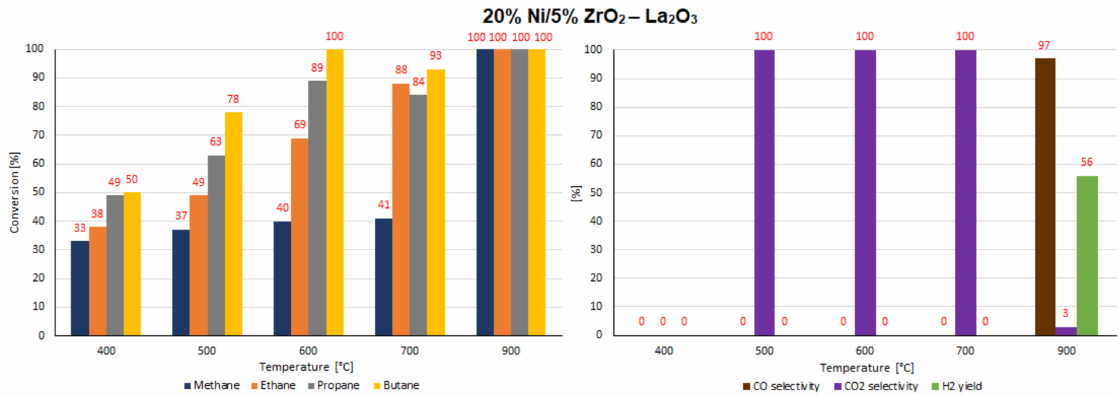
Figure 21. The activity results of the 20% Ni/5% ZrO 2 –La 2 O 3 catalyst in the OSR-LNG